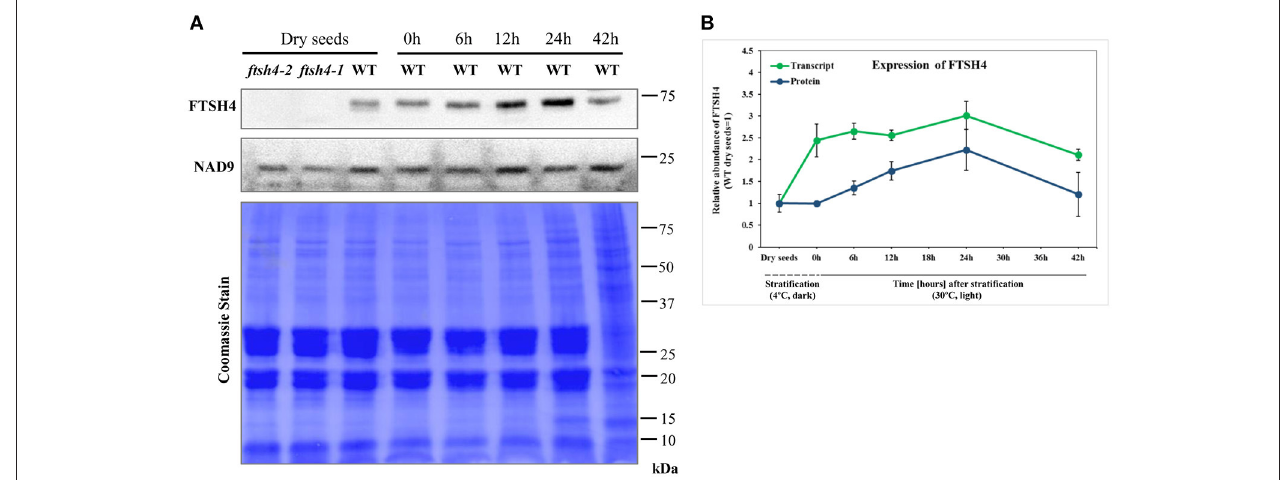
FIGURE 3 | Western blot analysis of FTSH4 abundance in Arabidopsis seeds. (A) Total seed protein extract has been obtained from wild-type (Col-0) dry seeds, seeds that were stratified at 4 ◦ C for 48h and not germinated (0h) as well as seeds which after stratification were subjected to germination under long-day photoperiod (LD) and 30 ◦ C for 6, 12, 24, and 42h. The samples were separated by SDS-PAGE (12%), transferred onto a membrane and subjected to immunodetection with antibodies anti-FTSH4. NAD9 protein levels are shown as a control. Membrane stained with Coomassie Brilliant Blue (CBB) is presented to show an equal loading. (B) Quantification of FTSH4 abundance at the level of transcript (in green) and protein (in blue) in dry, stratified and germinating at 30 ◦ C wild-type seeds. Transcript abundance was quantified with qRT-PCR. The values are given as relative to the value obtained for dry seeds (set as 1). Protein amount was quantified densitometrically using ImageJ (Fiji) based on immunodetection with antibodies directed against FTSH4 as well as Ponceau S or CBB (Coomassie Brilliant Blue) staining of the membrane as a loading control. The values are given as relative to the value obtained for dry seeds (set as 1). Mean values ± SD from at least three independent experiments are